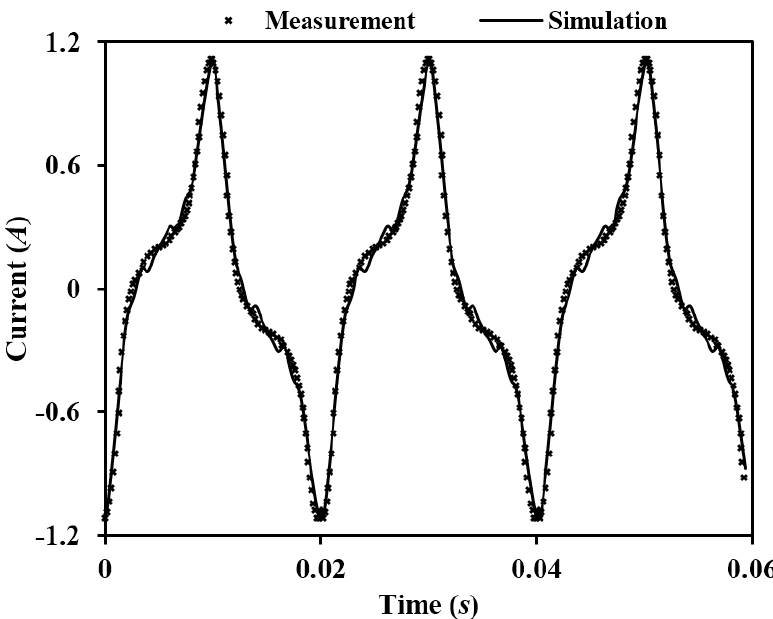
Figure 10. Comparison of the simulation and measurement results of the exciting current under the square excitation ( B peak = 1.5 T, f = 50